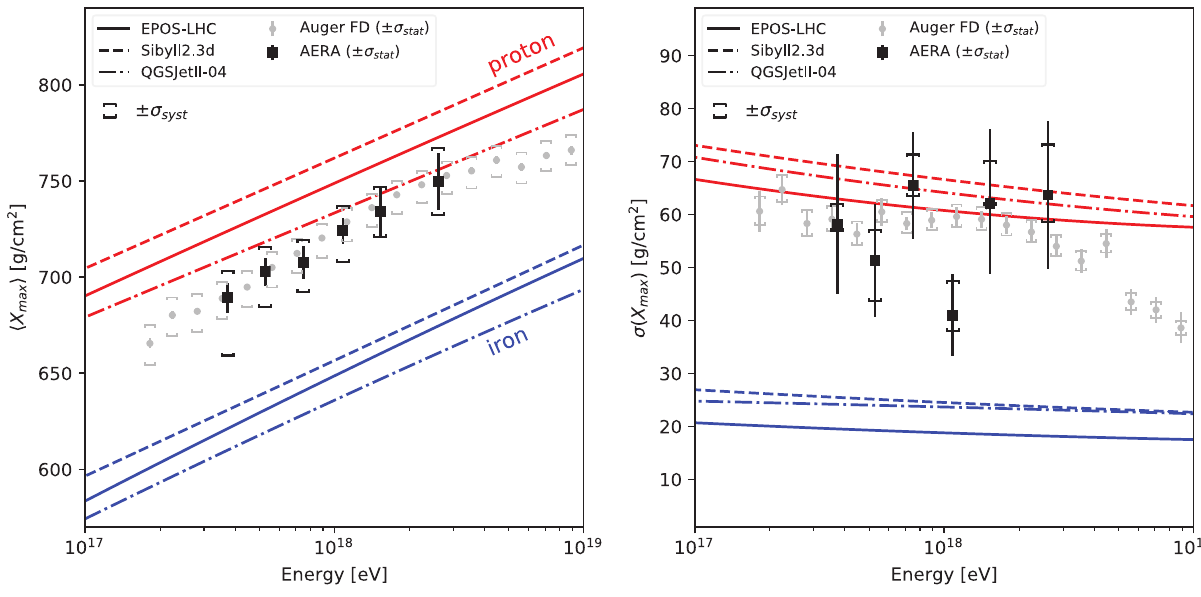
Figure 3. Mean (left) and width (right) of X max for our measurements (black markers), Auger FD measurements [13] (gray markers), and pure proton and iron nuclei composition from air shower simulations using three di ff erent hadronic interaction models (red and blue lines) [13]. Statistical uncertainties are shown with error bars and systematic uncertainties (see also Fig. 4) with caps.